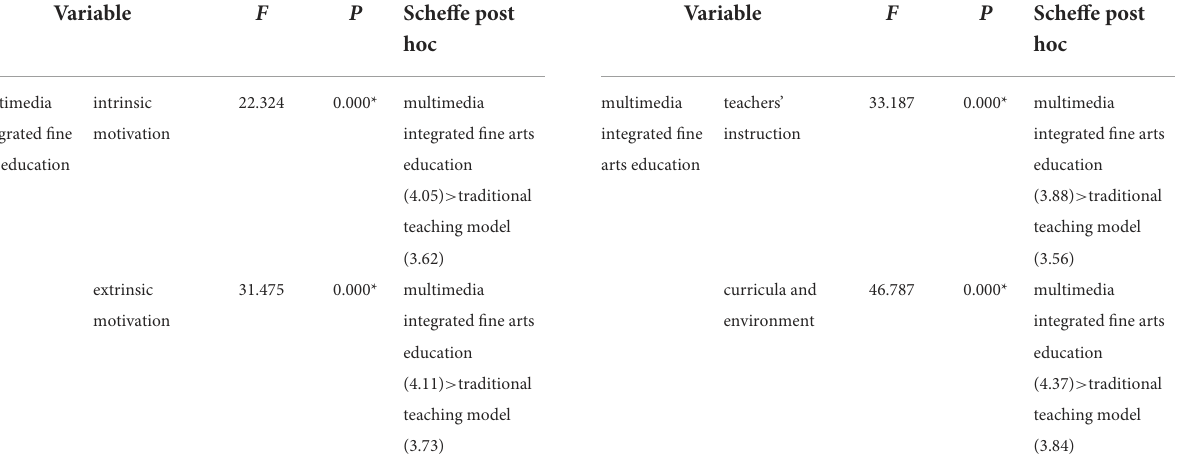
TABLE 1 Difference analysis of multimedia integrated fine arts education in terms of learning attitude.